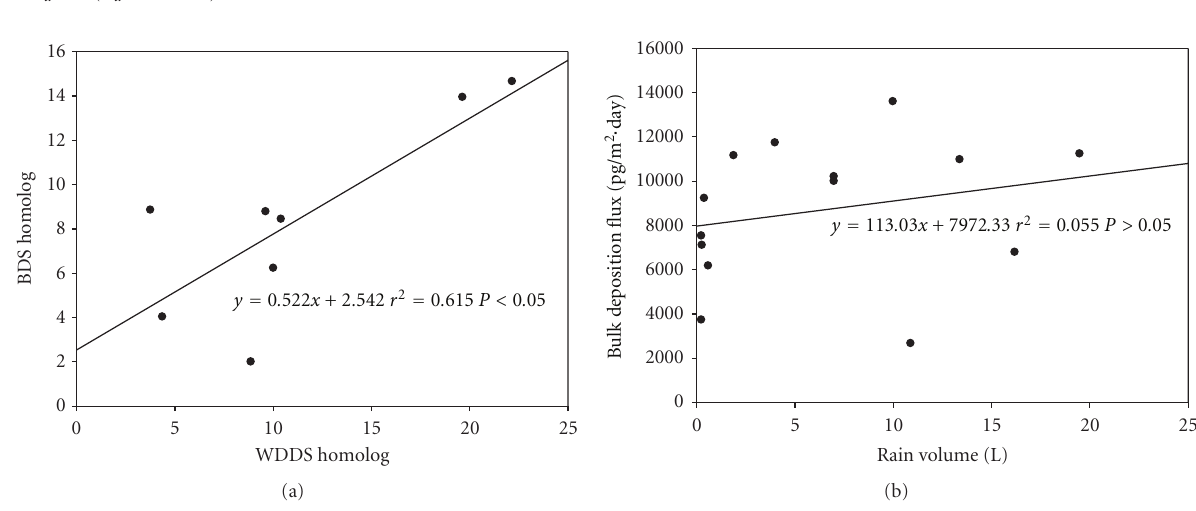
Figure 5: (a) Relationship between WDDS homolog distributions and BDS homolog distributions, and (b) relationship between rainy period bulk deposition fluxes and rain